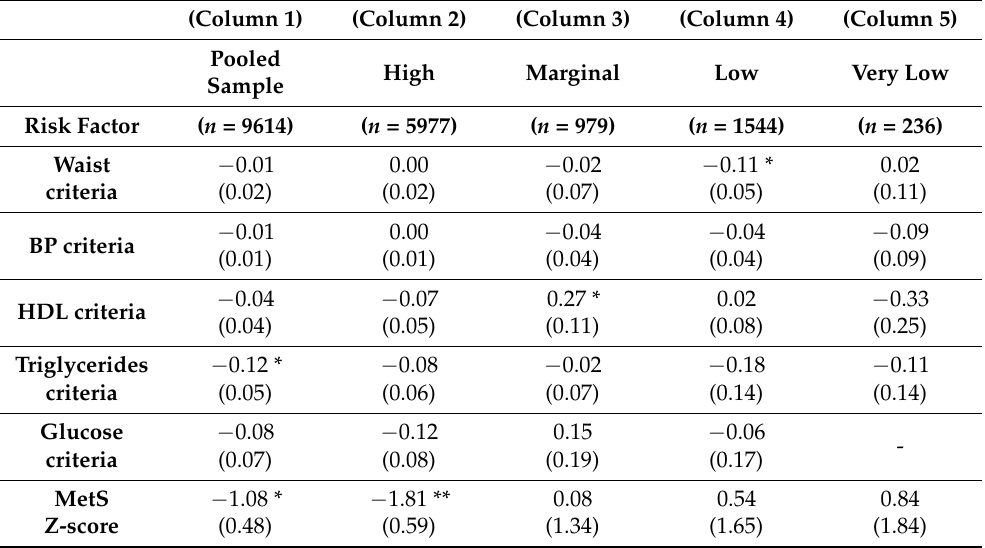
Table 2. Estimated effect of SNAP eligibility on cardiometabolic risk factors in children and adoles- cents compared to those just over the eligibility threshold: differences across food